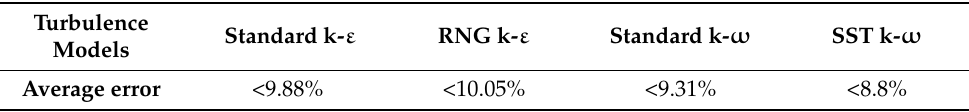
Table 10. Average errors (%) between numerical results of the velocity profiles with experimental data [1].